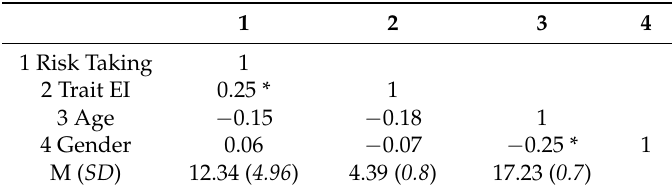
Table 1. Means, standard deviations and intercorrelations between trait EI, gender, age and risk taking. 1 2 3 4 1 Risk Taking 1 2 Trait EI 0.25 * 1 3 Age −